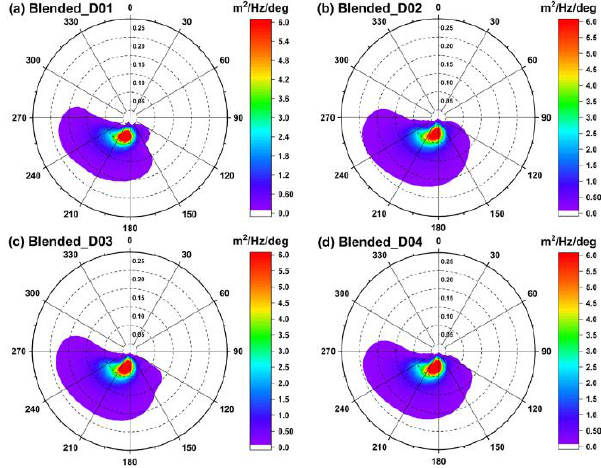
Figure 24. Comparison of the directional wave spectra at the Suao wave buoy at 00:00 on 27 September